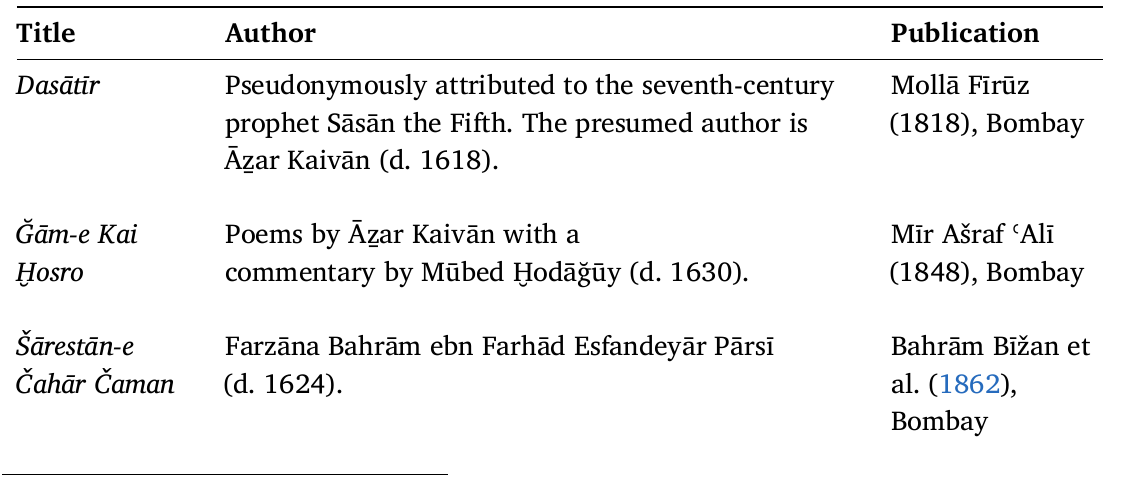
Table 1 The Eight Extant Books of the Āẕar Kaivān